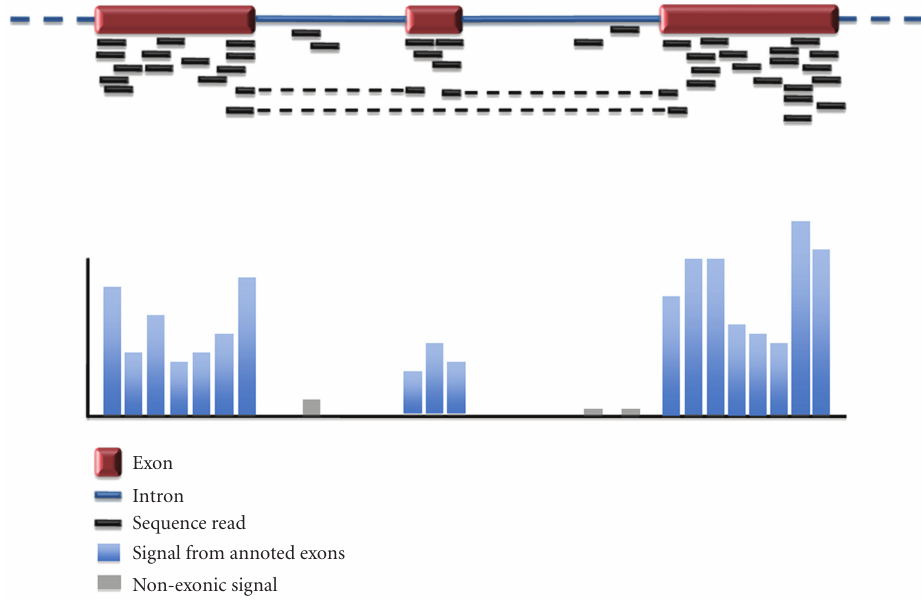
Figure 5: Mapping and quantification of the signal. RNA-seq experiments produce short reads sequenced from processed mRNAs. When a reference genome is available the reads can be mapped on it using e ffi cient alignment software. Classical alignment tools will accurately map reads that fall within an exon, but they will fail to map spliced reads. To handle such problem suitable mappers, based either on junctions library or on more sophisticated approaches, need to be considered. After the mapping step annotated features can be